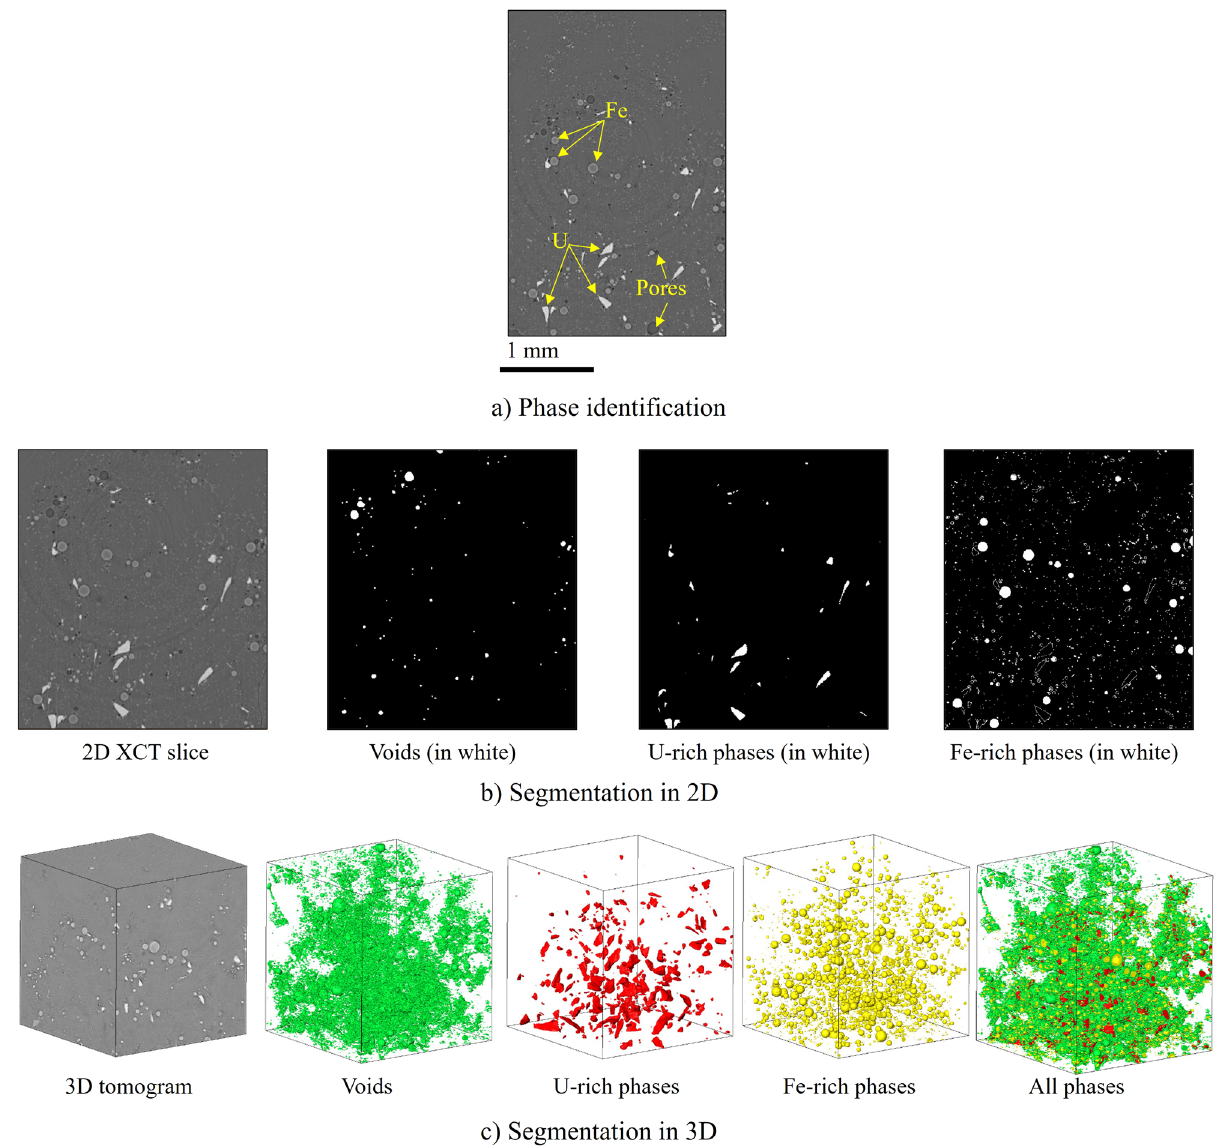
Fig. 2 Representative 2D and 3D images illustrating the multiphase nature of the MCCI simulant. a Identi fi cation of pores, uranium and iron phases, b segmentation of the several phases in a 2D slice, and c 3D volumes of the segmented uranium, iron and pore